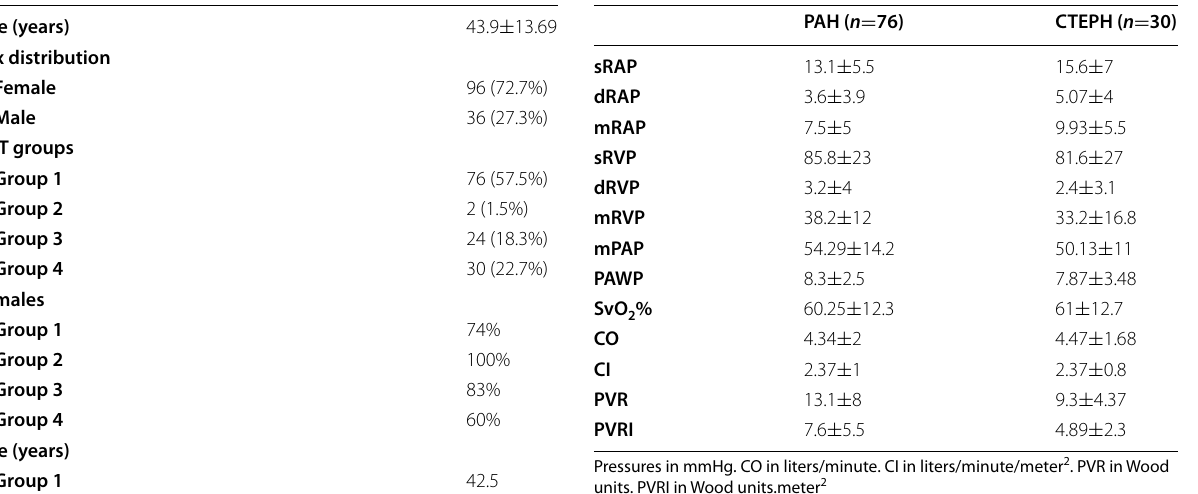
Table 3 Hemodynamic parameters of PAH and CTEPH groups